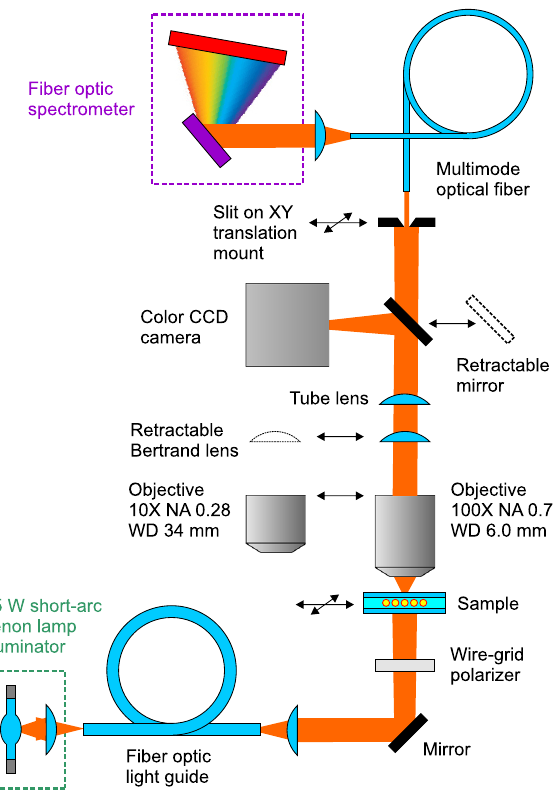
Figure 7: Schematic of experimental setup used for BFP